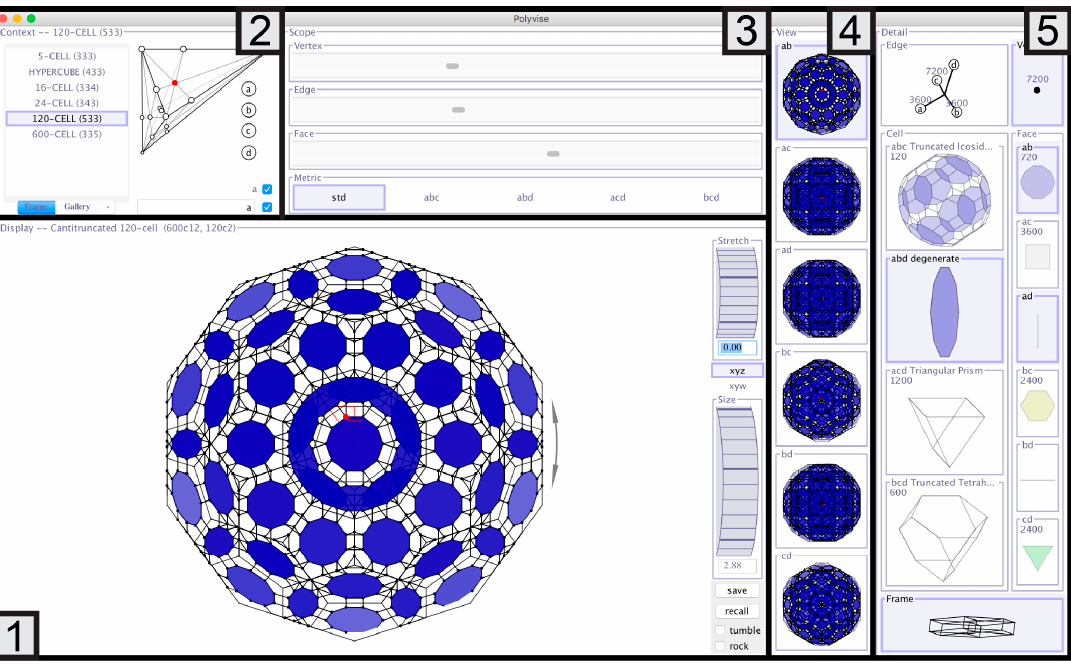
Figure 3. A screen capture of Polyvise’s interface, which has five main components: Display ( 1 ); Context ( 2 ); Scope ( 3 ); View ( 4 ); and Detail ( 5 ). Labels of combinations of letters a, b, and c indicate their planes.